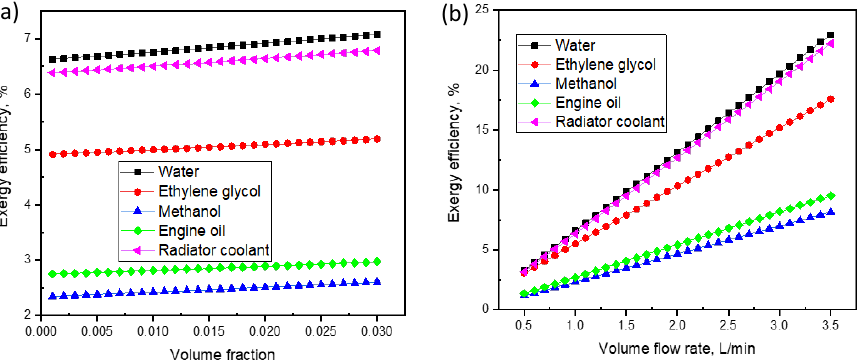
Figure 1. Effect of a particle ( a ) volume fraction and ( b ) volume flow rate on Exergy Efficiency.